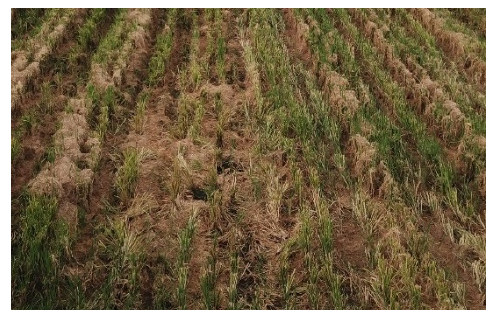
Figure 4. Rotten straw.